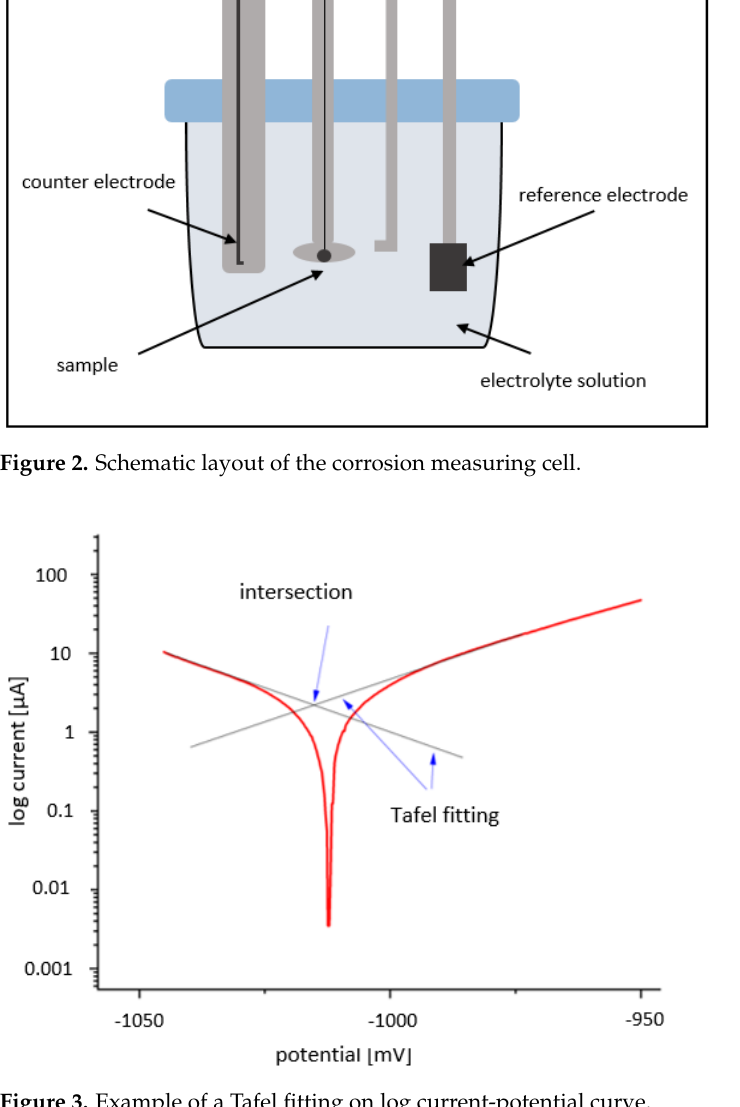
Figure 3. Example of a Tafel fitting on log current-potential curve.